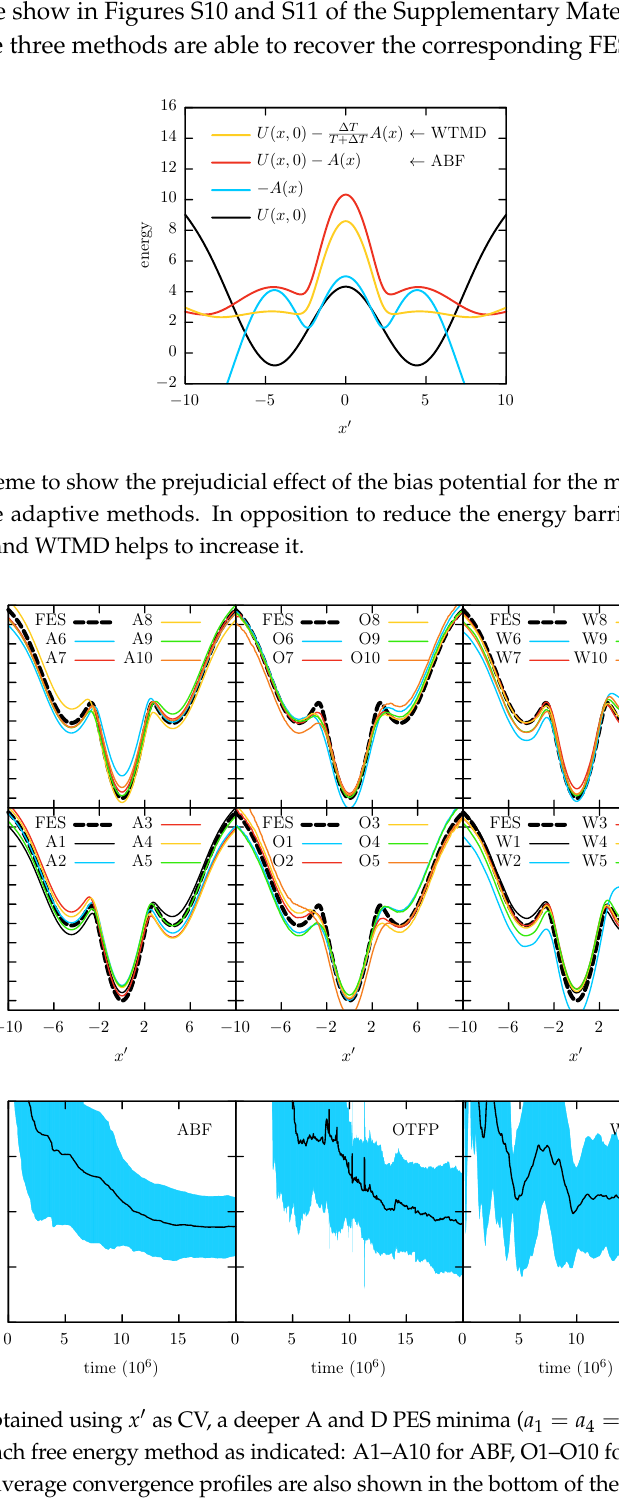
Figure 9. FEPs obtained using x (cid:48) as CV, a deeper A and D PES minima ( a 1 = a 4 = 22.5) and 10 different simulations for each free energy method as indicated: A1–A10 for ABF, O1–O10 for OTFP and W1–W10 for WTMD. The average convergence profiles are also shown in the bottom of the figure. The light blue region corresponds to one standard deviation. This profiles shows the expected convergence of each individual simulation and should not be confused with the convergence of the average FEP profile. For the average FEP and the individual convergence profiles see Figure S9 in the Supplementary